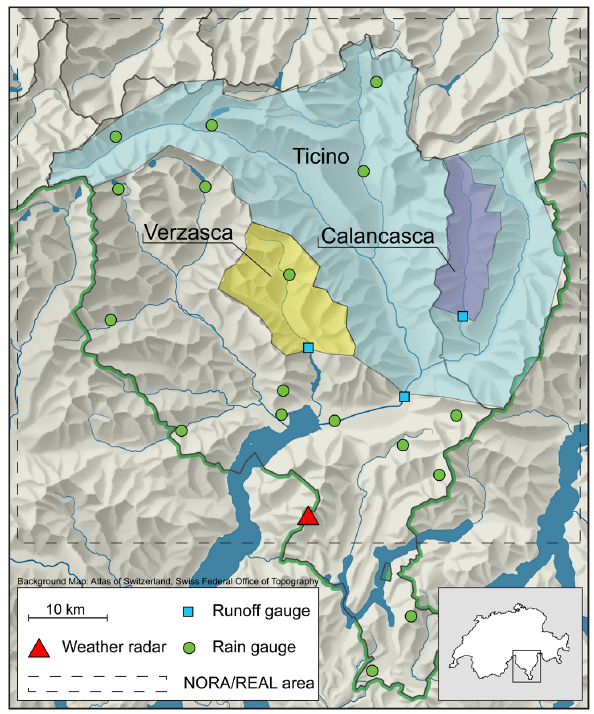
Fig. 1. Lago Maggiore region, southern Switzerland, with test catchments, meteorological and hydrological stations and weather radar used in this study. The rectangle with dashed lines shows the area for which NORA and REAL have been